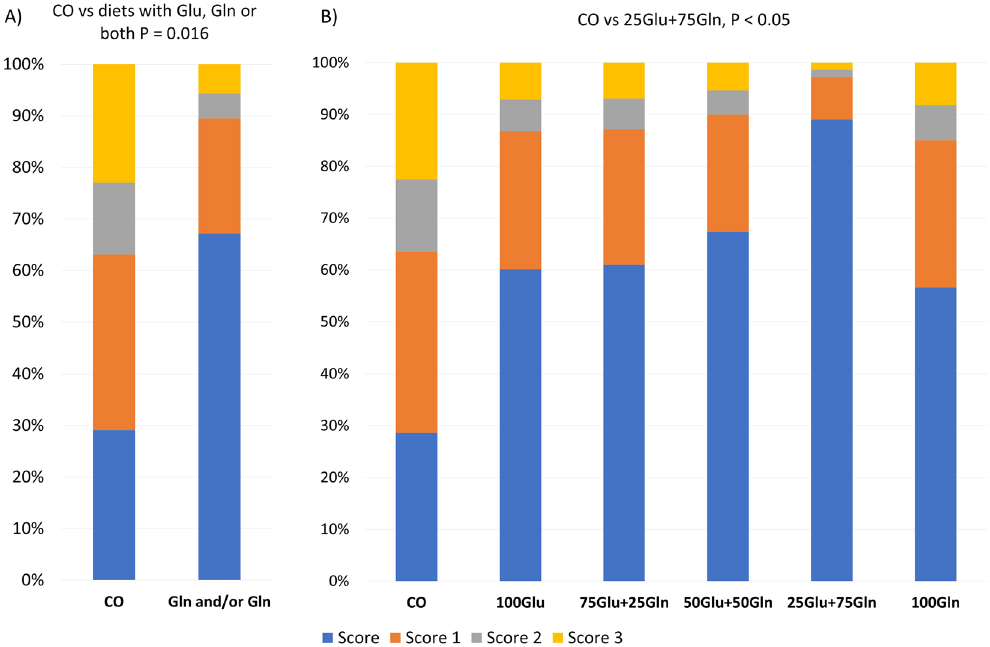
Figure 3. The effect of the diet on the cumulative probabilities of having each score for the intraepithelial lymphocytes in the jejunum of piglets at 8 days post-weaning. ( A ) Comparison between the CO group and the groups supplemented with AAs; ( B ) Cumulative probabilities of having each score in each dietary group . Diet: CO = standard diet; 100Glu = CO plus 6 kg/Ton Glu; 75Glu + 25Gln = CO plus 4.5 kg/Ton Glu and 1.5 kg/Ton